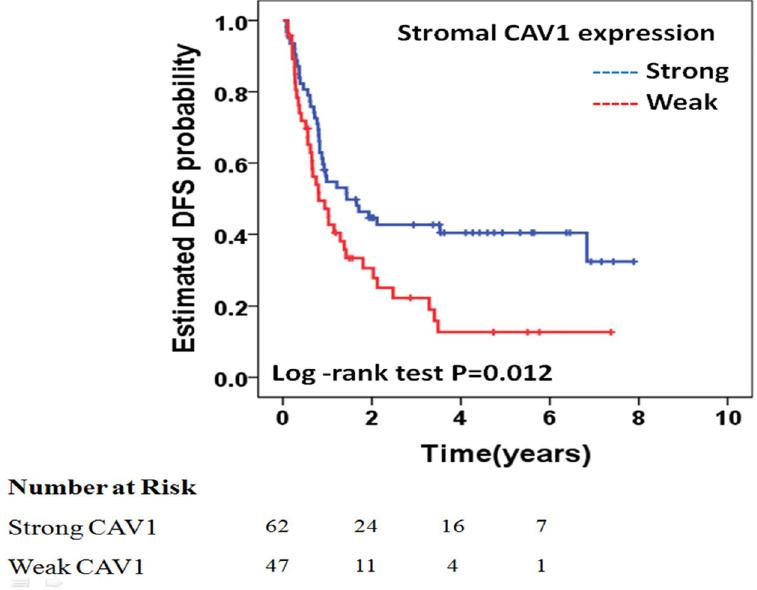
Figure 2. Kaplan–Meier analysis. Stromal CAV1 expression and disease-free survival. Weak stromal CAV1 expression is associated with a decreased DFS.